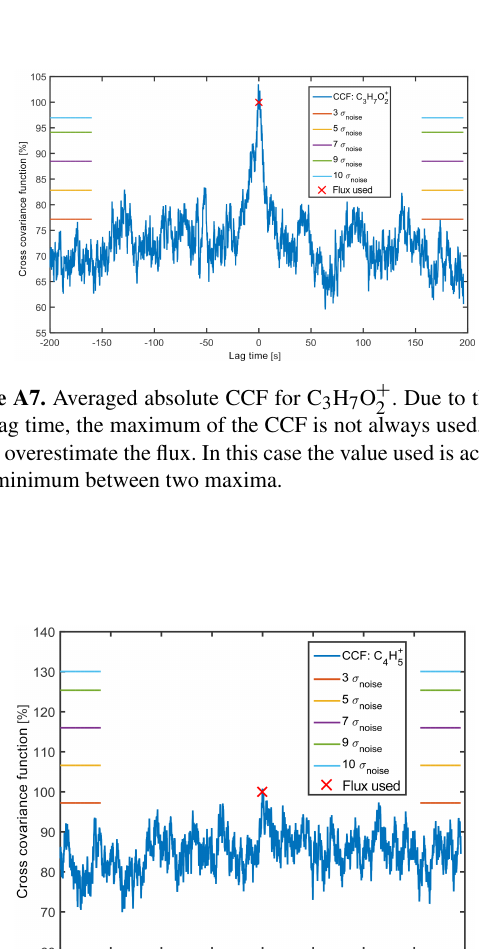
Figure A5. Thirty-minute absolute normalized cross covariance function of C 3 H 7 O + from 15 June 2012, 14:15. The red lines at the 1 corners of the plot indicate the average noise, while the cyan lines are the 3 σ noise threshold (in the legend the 39% represents just the 3 σ noise , while in the plot it is added to the mean noise). Taking the absolute of a CCF increases the mean value and thereby reduces the standard deviation of the noise (compare with Fig. A4).